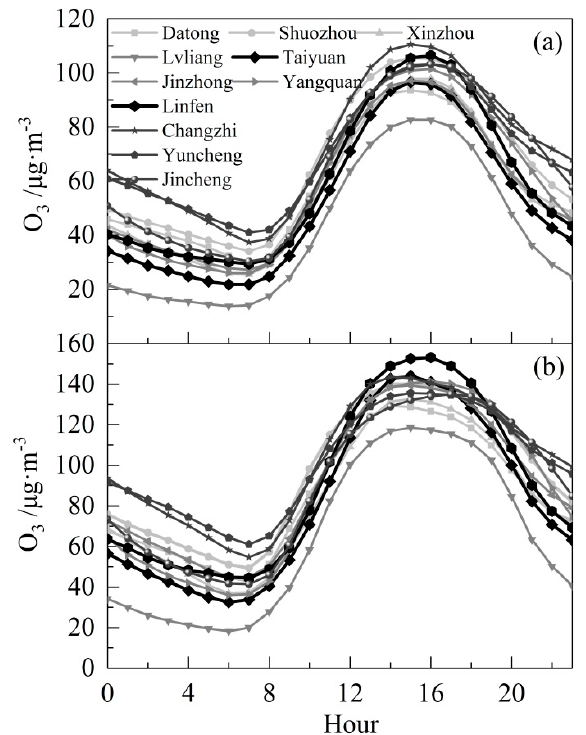
Figure 7. The daily variation of mean hourly surface O 3 mass concentration in the entire year ( a ) and the period from May to August ( b ) in 11 cities of Shanxi Province during 2015 − 2020.